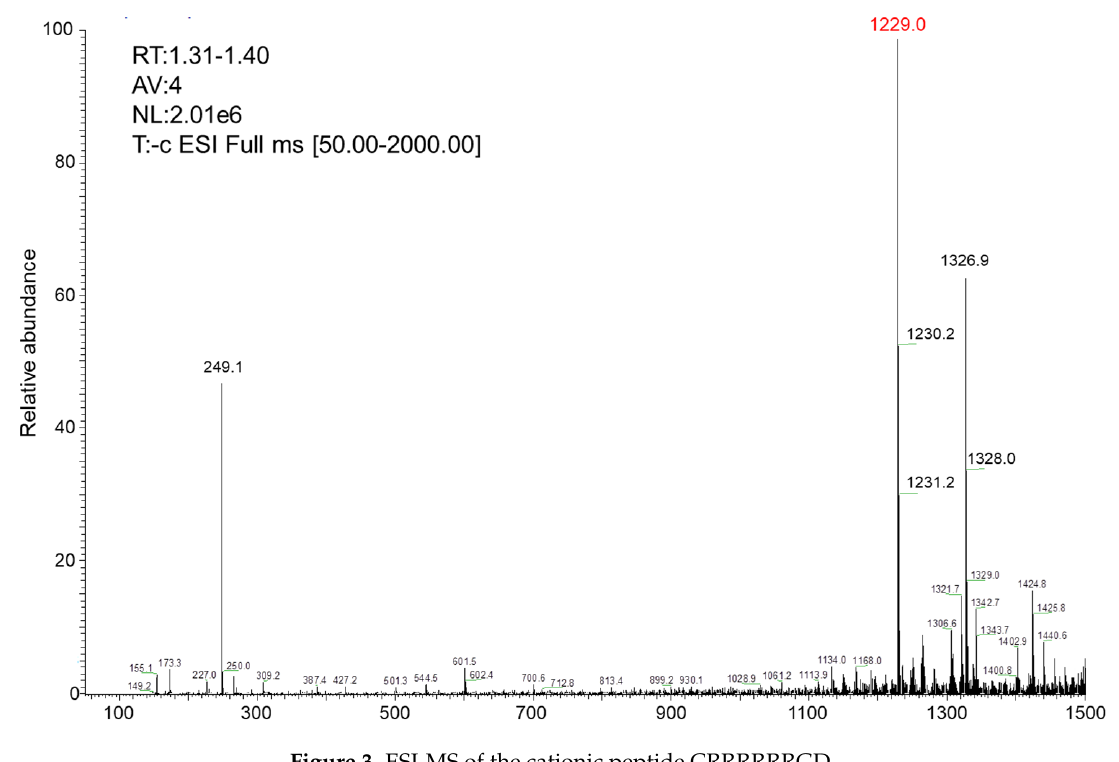
Figure 3. ESI-MS of the cationic peptide CRRRRRRGD. Table 1. ESI-MS analysis of tumor-targeting peptide.